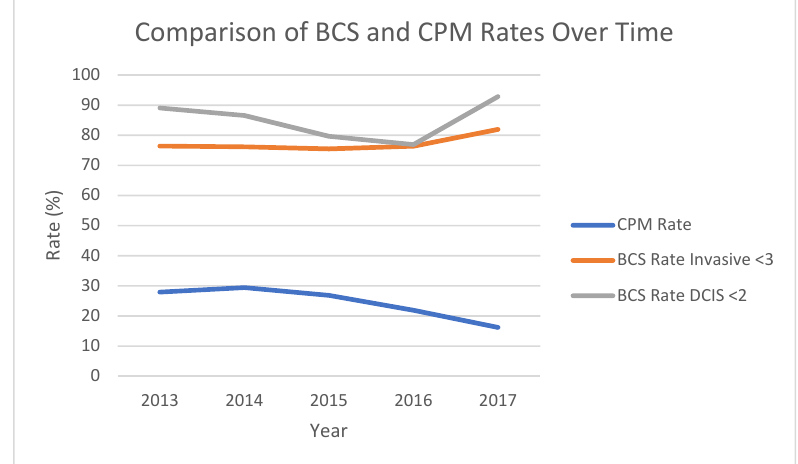
Figure 2. Time trends in BCS rate for invasive cancer, BCS rates for DCIS and CPM rates.